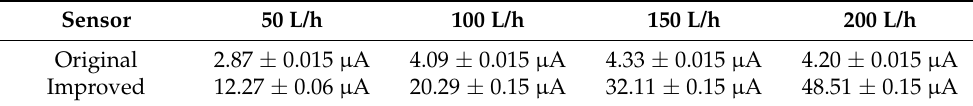
Table 7. Comparison of the average ion current from the original and improved sensor.